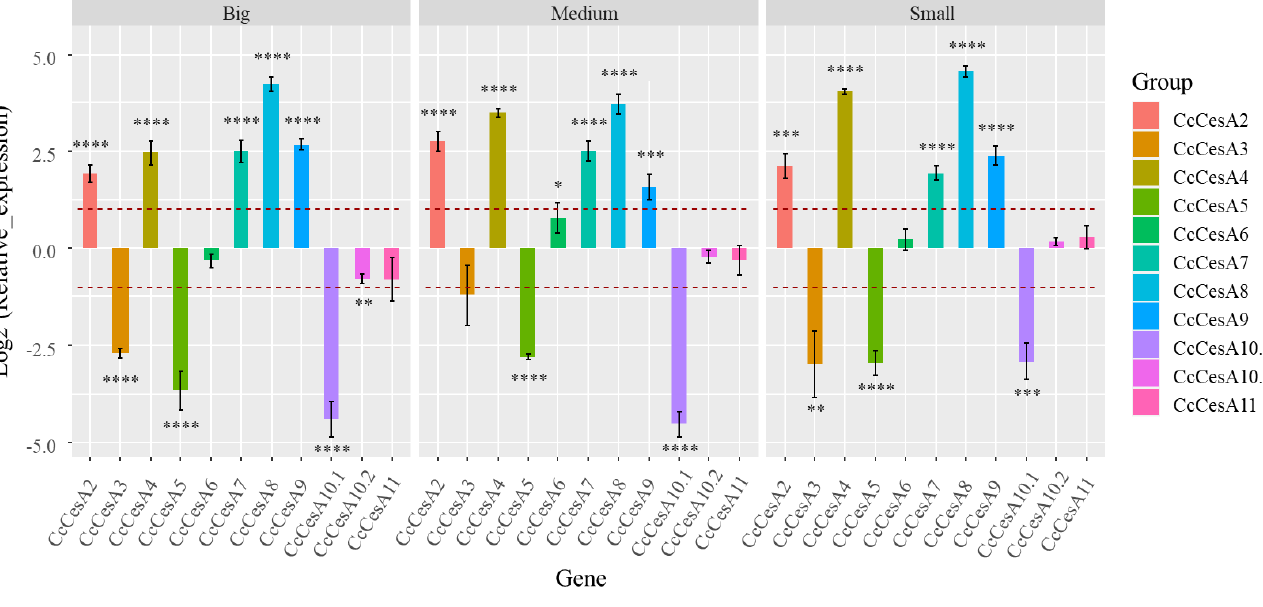
Figure 9. The CcCesA gene family was expressed in small, medium, and large DBH, respectively. Each treatment was controlled by CcCesA1 (relative expression level was close to 1). The two red dotted lines are located at 1 and −1 on the Y-axis. Error bars indicate standard error of four biological replicates. * p ≤ 0.05, ** p ≤ 0.01, *** p ≤ 0.001, **** p ≤ 0.0001.